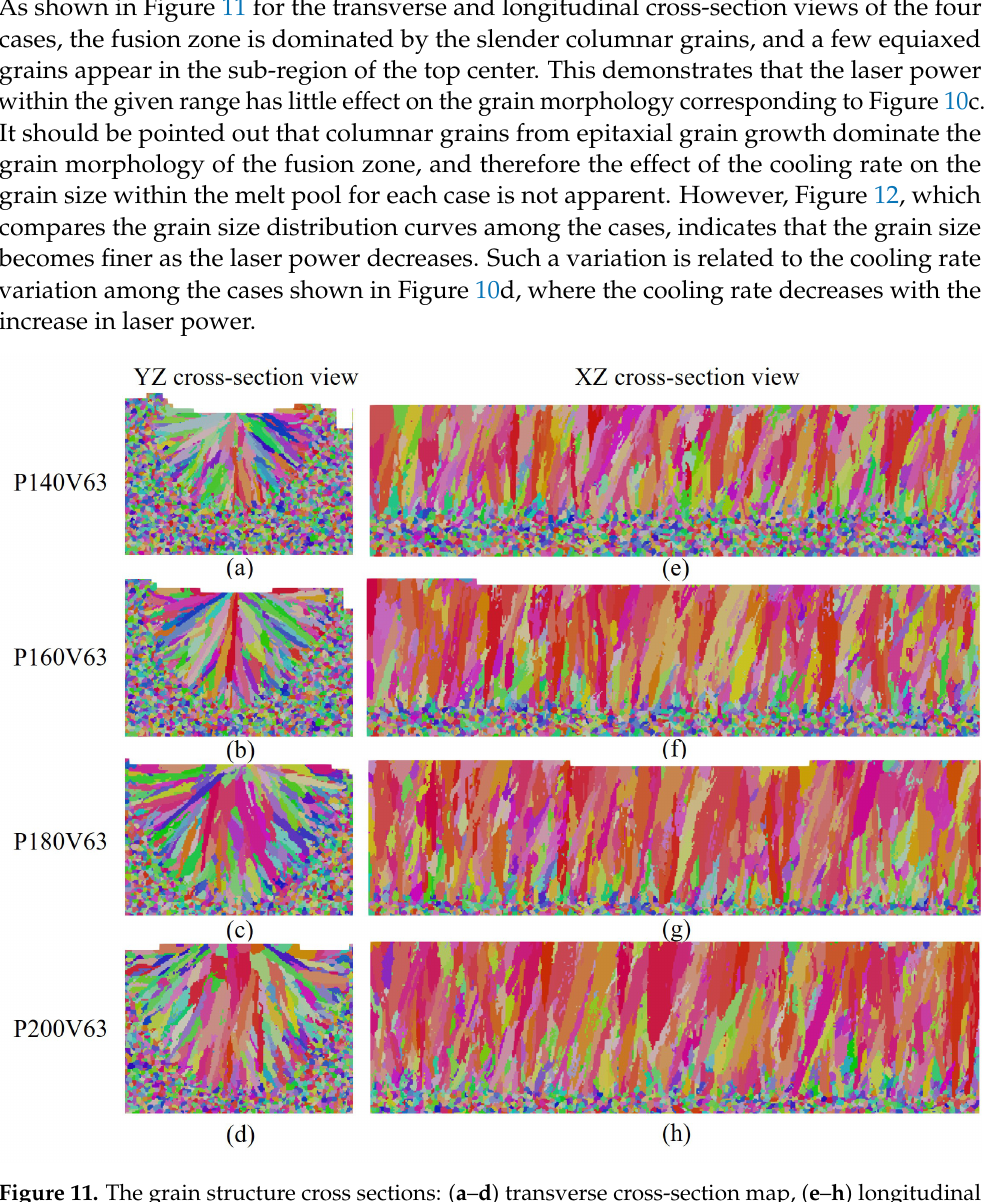
Figure 11. The grain structure cross sections: ( a – d ) transverse cross-section map, ( e – h ) longitudinal cross-section map of the results for cases with laser power varied within the range of [140 W, 200 W], and the constant laser scan speed of 0.63